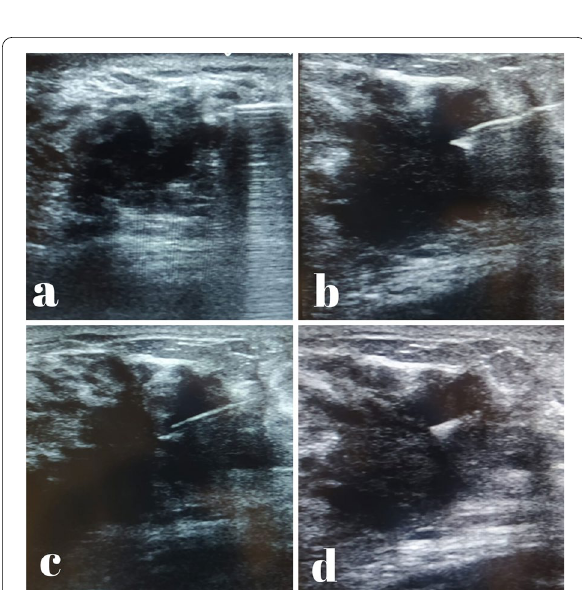
Fig. 2 A case of pathologically proved infiltrating ductal carcinoma (IDC). a The spinal needle at the margin of the mass. b The spinal needle enters the malignant mass. c The needle at the center of the mass and d The clip at the center of the mass after withdrawal of the